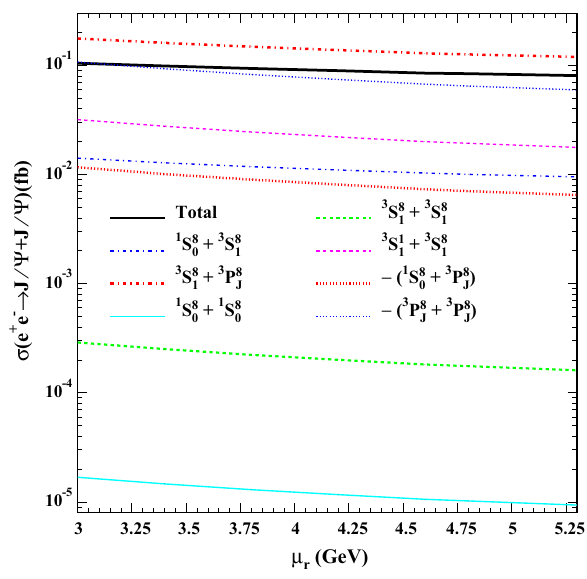
Fig. 3 σ as a function of μ r . The c-quark mass is fixed to m c = 1 . 5 GeV